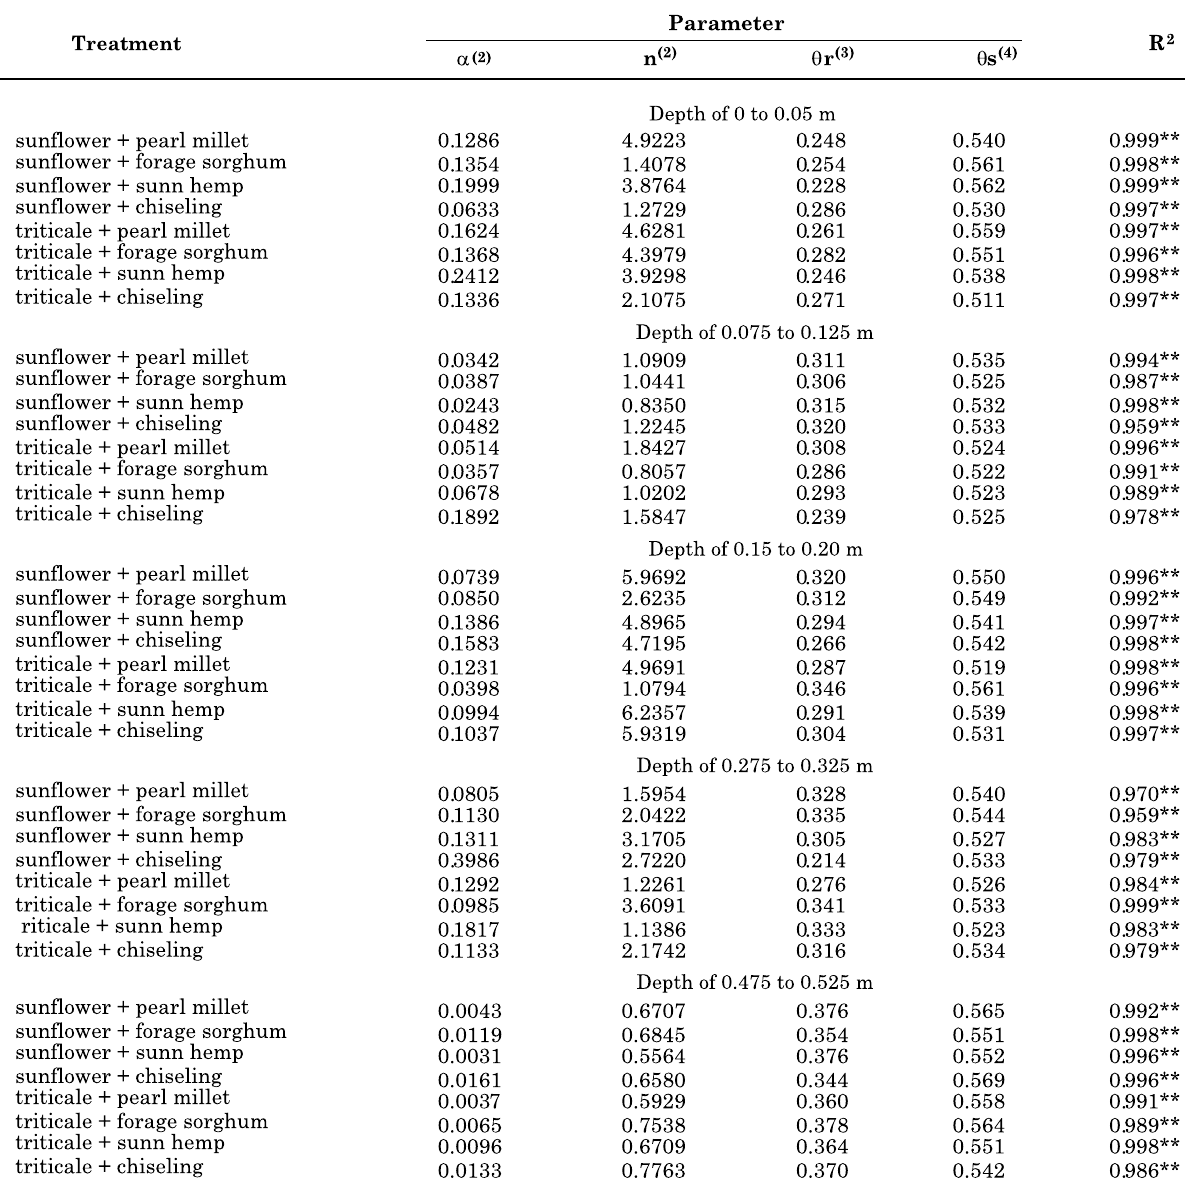
Table 3. Estimated regression coefficients for the water retention curve (WRC) (1) at the 0 to 0.05, 0.075